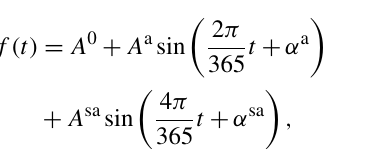
Fig. 6. The following function was